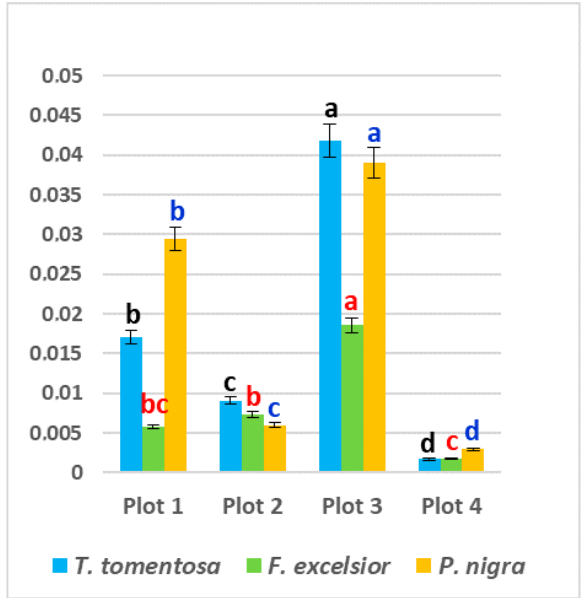
Figure 5. Activity of guaiacol peroxidase (GPX) (U mg − 1 protein) in leaves of studied tree species, planted in four urban plots with different types and intensity of anthropogenic impact. For each tree species ( Tilia tomentosa in black, Fraxinus excelsior in red; Pinus nigra in blue), means showing different letters are significantly different according to Student’s LSD comparison test ( p < 0.05).